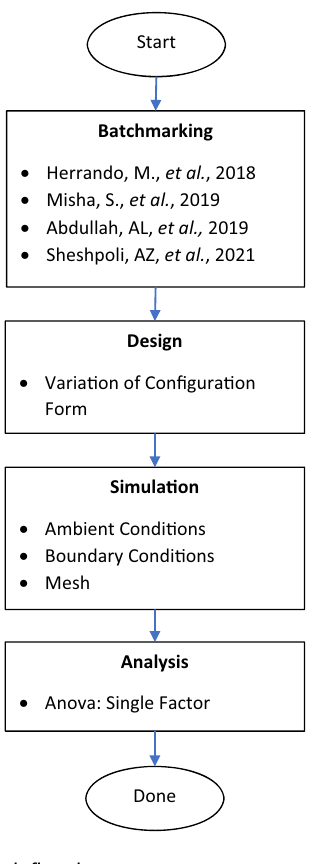
Figure 2: Research fl owchart.